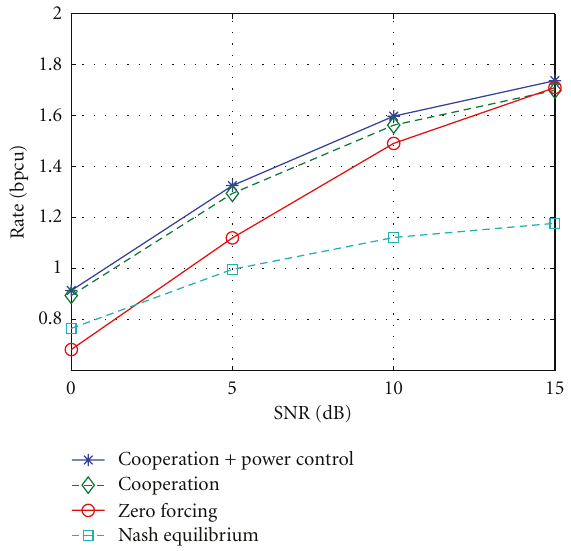
Figure 5: Average rates for the di ff erent transmission schemes with 2-antennas at the basestation for varying average SNRs (all channels are i.i.d. Rayleigh